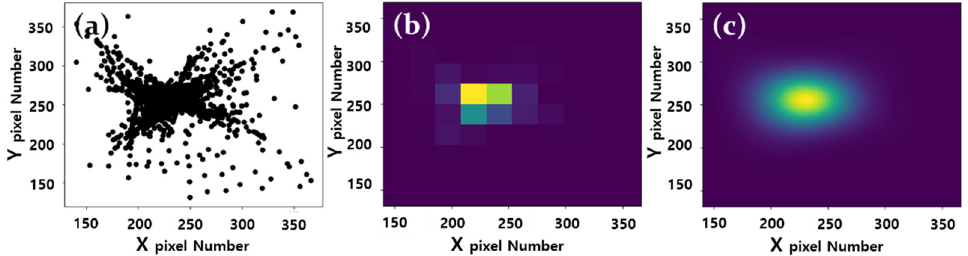
Figure 6. An example of the maximum density selection of ( a ) intersection points of the rotation vector normal lines using the ( b ) two-dimensional histogram and ( c ) kernel density function technique